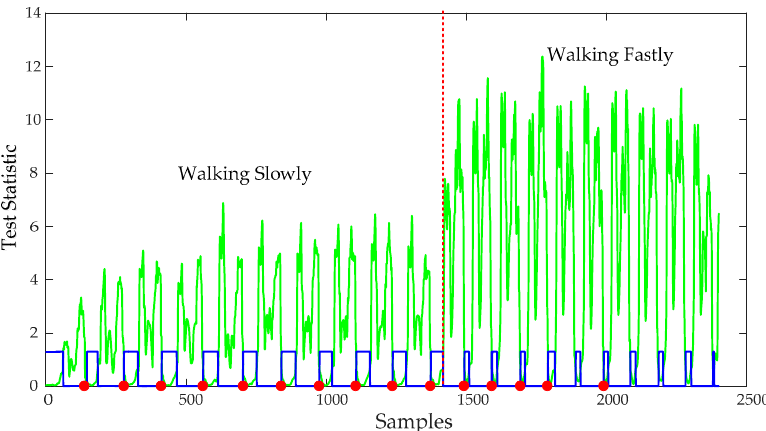
Figure 4. The zero-velocity interval's detection results for the fixed threshold-based detection algorithm when a pedestrian walks at different speeds. The blue line denotes the gait, the large values indicate the still-phase, while the small values indicate the swing-phase; the red dots denote the start point of the still-phase; and the green line denotes the standard deviation of acceleration.